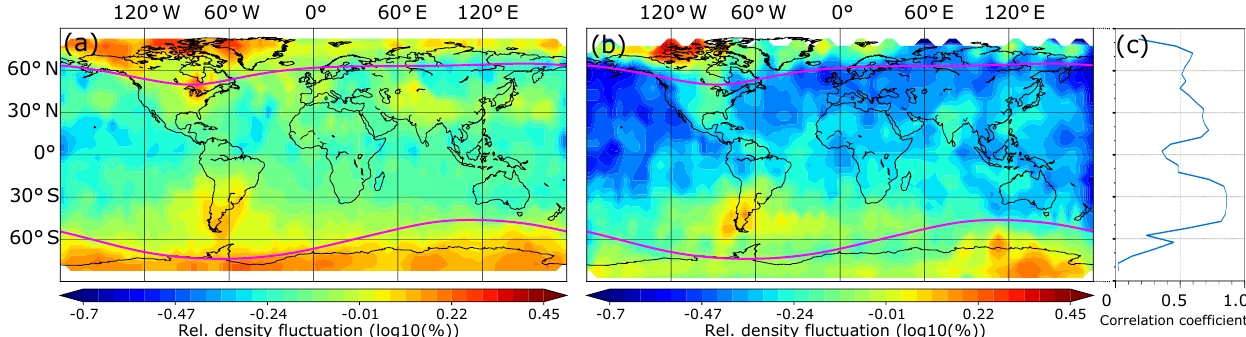
Figure 8. Horizontal distributions of ARDF for (a) GOCE satellite and (b) CHAMP satellite and (c) their spatial correlation coefficients for June 2010. Only data equatorward of 60 ◦ magnetic latitudes (magenta lines) are used for calculating